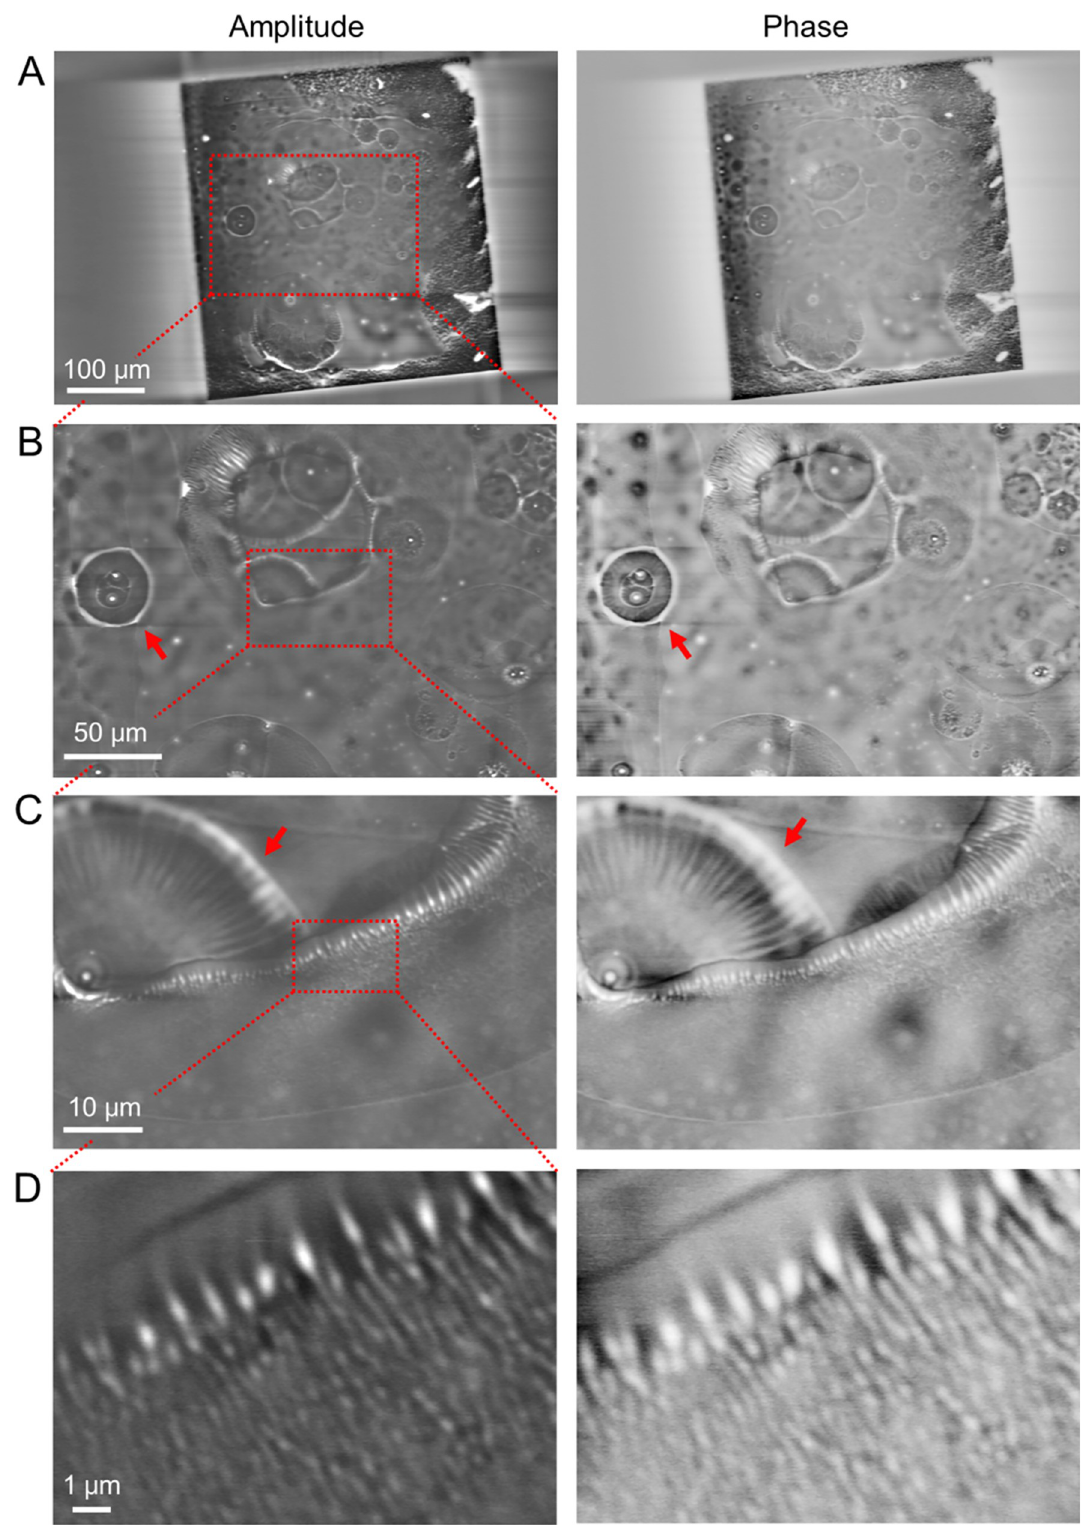
Fig 4. Amplitude and phase images of PLA beads in the bubble area of a wet environment observed by the IP-SEM system. (A) Amplitude and phase images of the 500 nm-diameter PLA beads in water with bubbles (EB accelerating voltage 5 kV, EB current 400